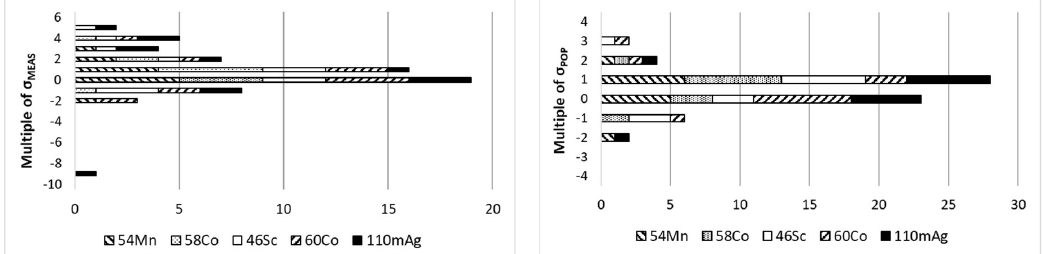
Figure 9 Discrepancies of mass-adjusted specific activities from mean relative to measurement uncertainties, σ meas (to the left) and relative to standard deviation, σ pop (to the